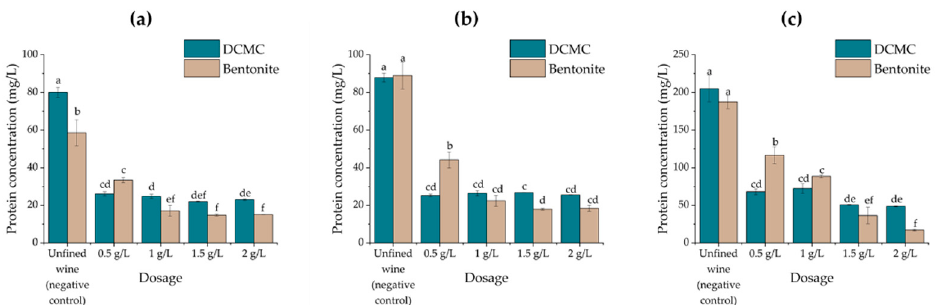
Figure 1. Protein concentration (mg/L; quantified by the Bradford method) in wine samples treated with increasing amounts of bentonite or DCMC. Different letters represent statistically significant differences among different homogeneous subsets for p = 0.05. ( a ) Encruzado, ( b ) Viosinho, and ( c ) Moscatel de Setúbal monovarietal wines.